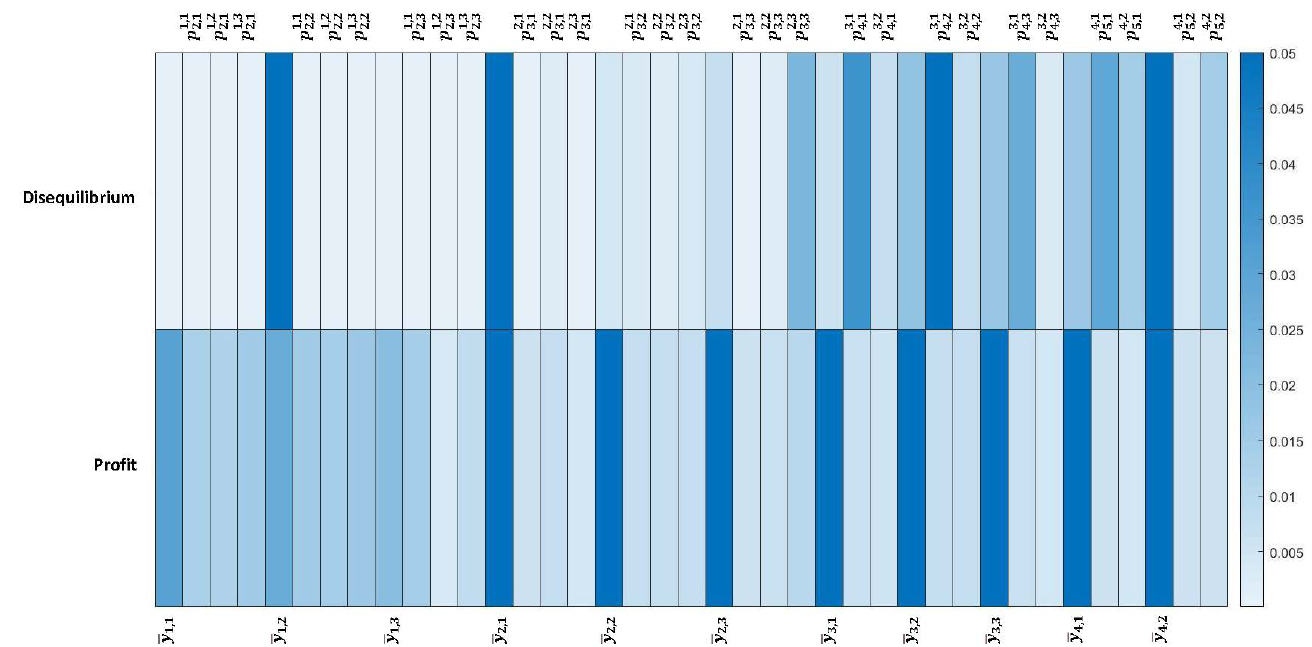
Table 4. The values of the unit prices o l + 1, v